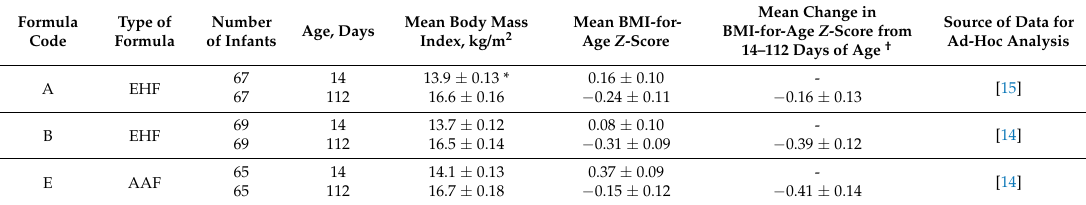
Table 4. Mean body mass index (BMI), BMI-for-age WHO z -score, and change in BMI-for-age WHO z -score from 14 to 112 days of age in evaluable healthy term infants fed formulas EHF-A, EHF-B, and